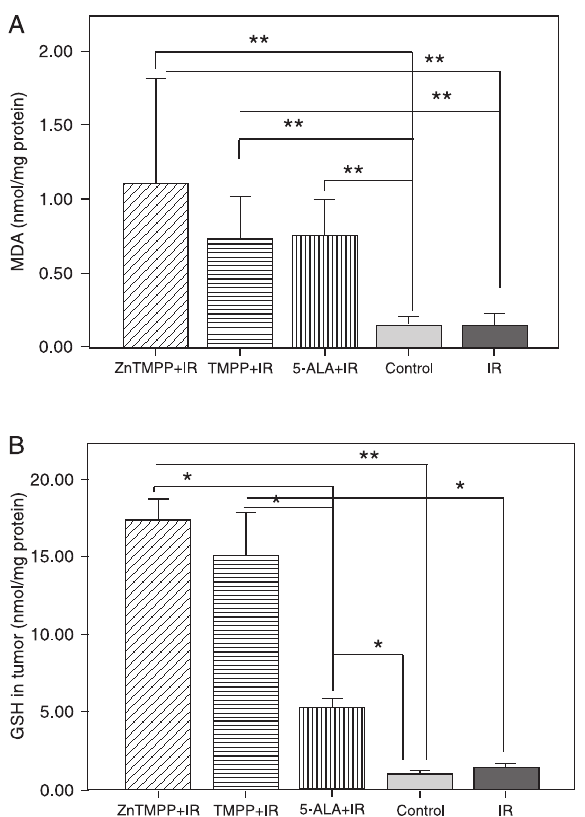
Figure 1. Parameters of oxidative stress (MDA) and antioxi- dant defense (GSH) in tumor tissue of Walker carcinosarcoma- bearing rats 24 h after photodynamic therapy with ZnTMPP, TMPP and 5-ALA. Data are reported as means ± SD of three independent experiments. MDA = malondialdehyde; TMPP = 5,10,15,20-tetrakis(4-methoxyphenyl)-porphyrin; ZnTMPP = TMPP zinc compound; 5-ALA = 5-aminolevulinic acid; GSH = reduced glutathione; IR = irradiation. Statistical analysis was done using the Mann-Whitney U-test and the Kruskal-Wallis test. A, MDA: **P < 0.01. B , GSH: *P < 0.05; **P <